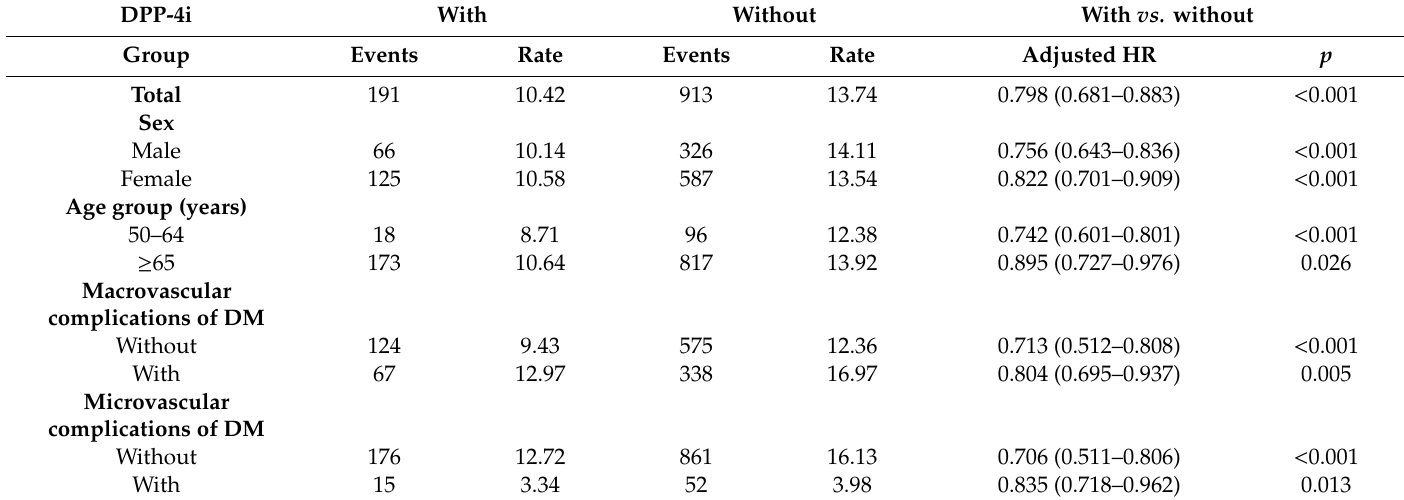
Table 3. Subgroup analyses on the use of DPP-4i according to sex, age, and microvascular and macrovascular complications of DM. DPP-4i With Without With vs.